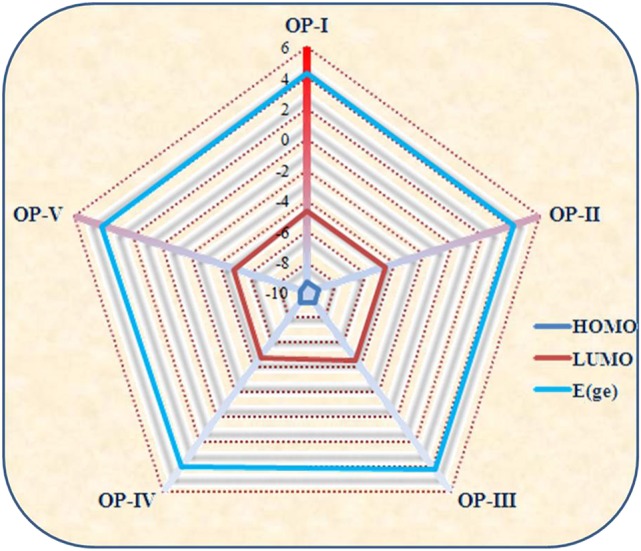
Graphical Abstract.